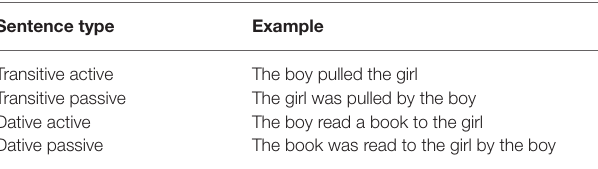
TABLE 3 | Examples of active-passive sentence types (adapted from Martin,